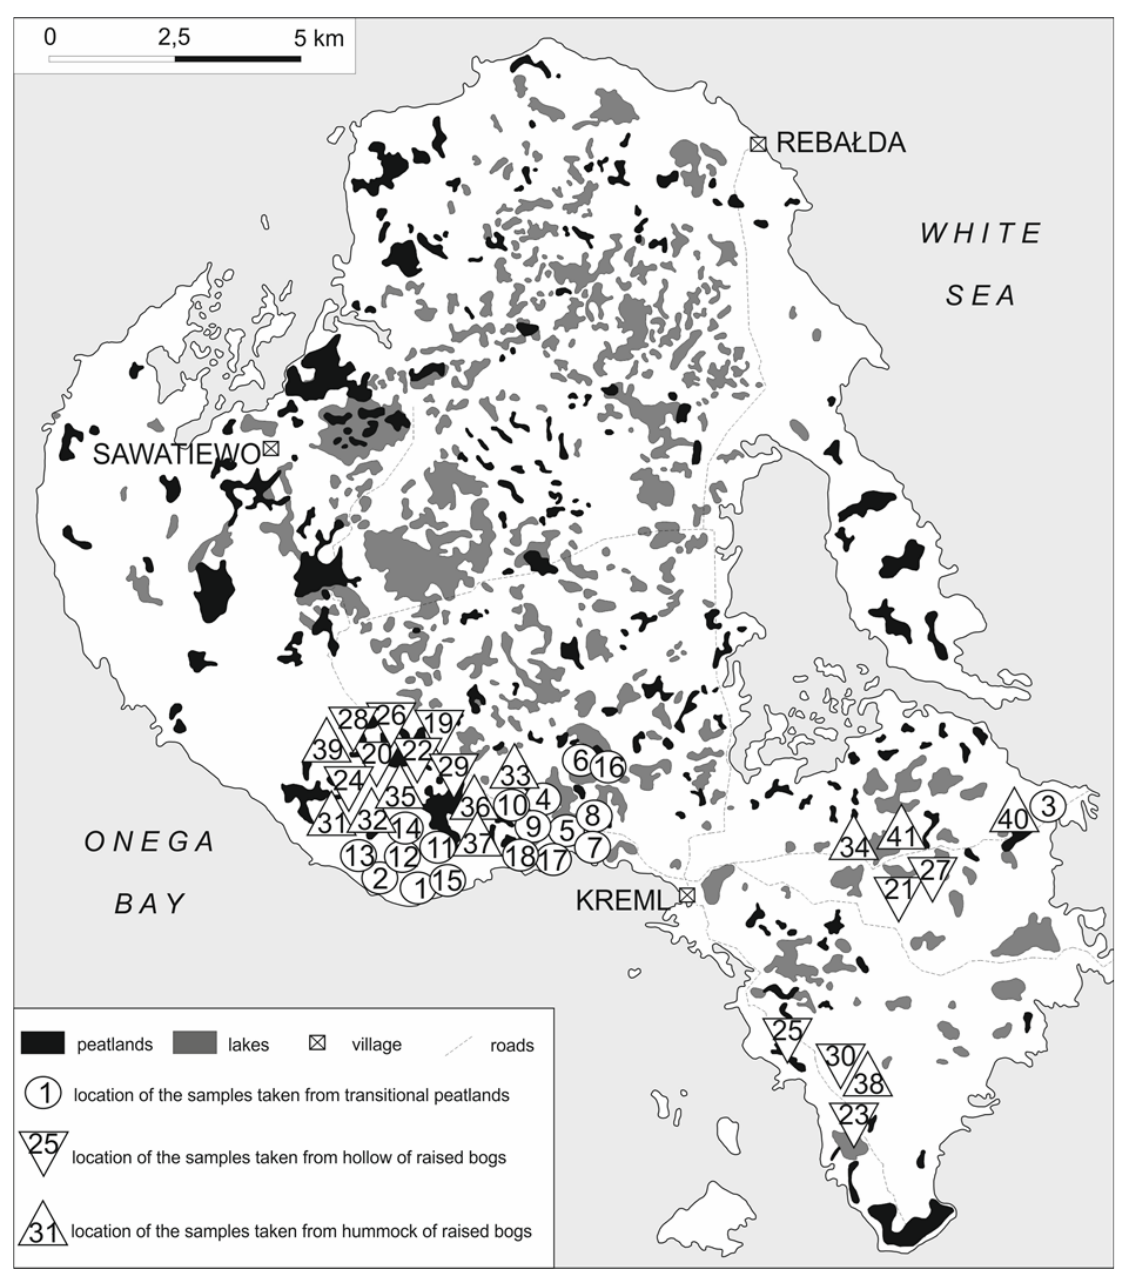
Figure 2. Map of Bolshoy Solovetsky Island showing the distribution of peatlands and lakes (Żurek 2007). samples were dissolved in a 8:2:2 (by